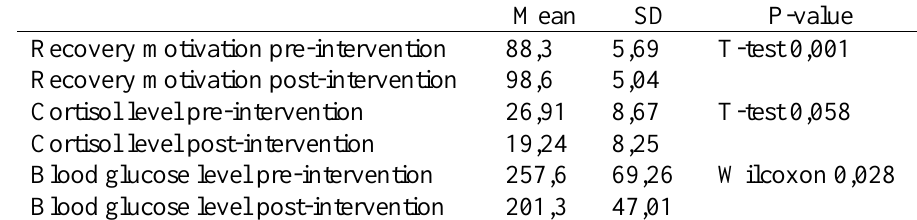
Table 1. Analyze result deferent test (pre-post) recovery motivation, cortisol and blood glucose level in intervention